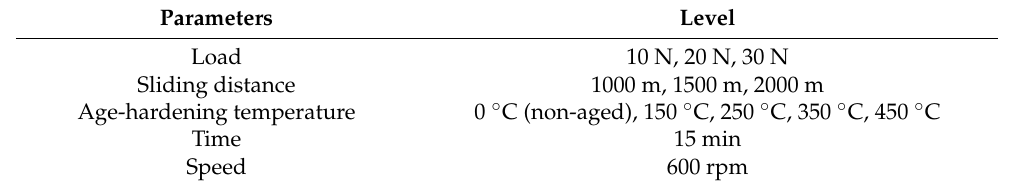
Table 5. Wear parameters.